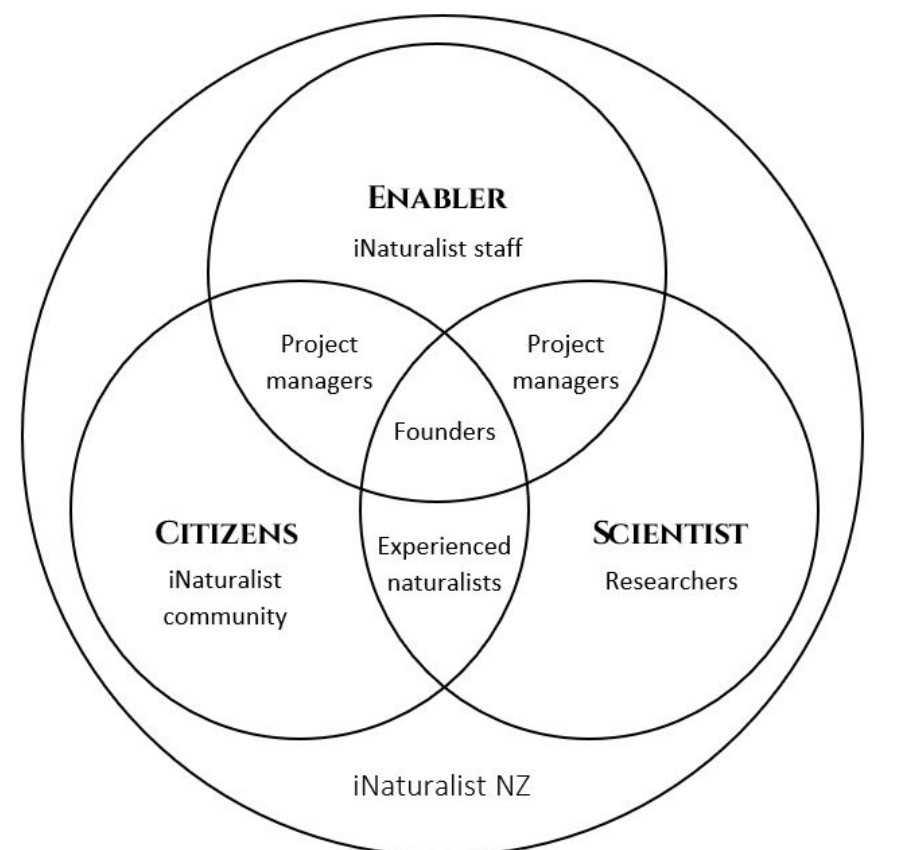
Figure 4. The tripartite model of citizen science applied to iNaturalist. Circles represent roles. Due to the nature of iNaturalist, individuals often occupied more than one role. Adapting our figure into a Venn-diagram allows us to visualise this overlap. Services provided by each role remain similar to Figure 1B. In this case enablers provide project management and technical services to the iNaturalist platform. We have omitted the inclusion of arrows in this case, in order to focus on the key insightof this case study, which was an improved depiction and acknowledgement of overlapping roles.